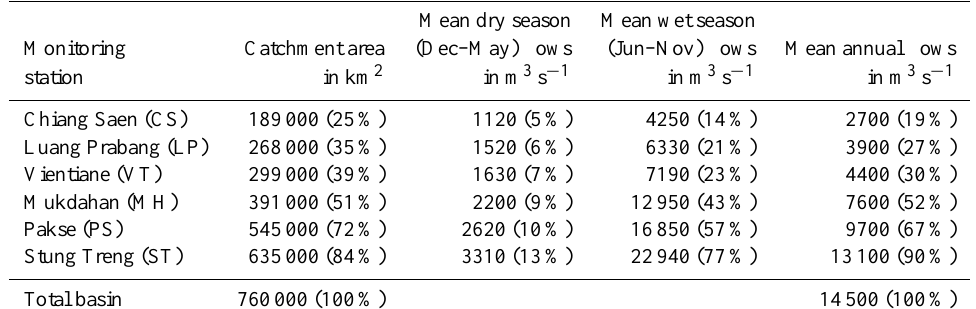
Table 1. Catchment areas and average historical seasonal flows (1960–2004) above each monitoring station. Source: MRC (2010) and verified with flow records.